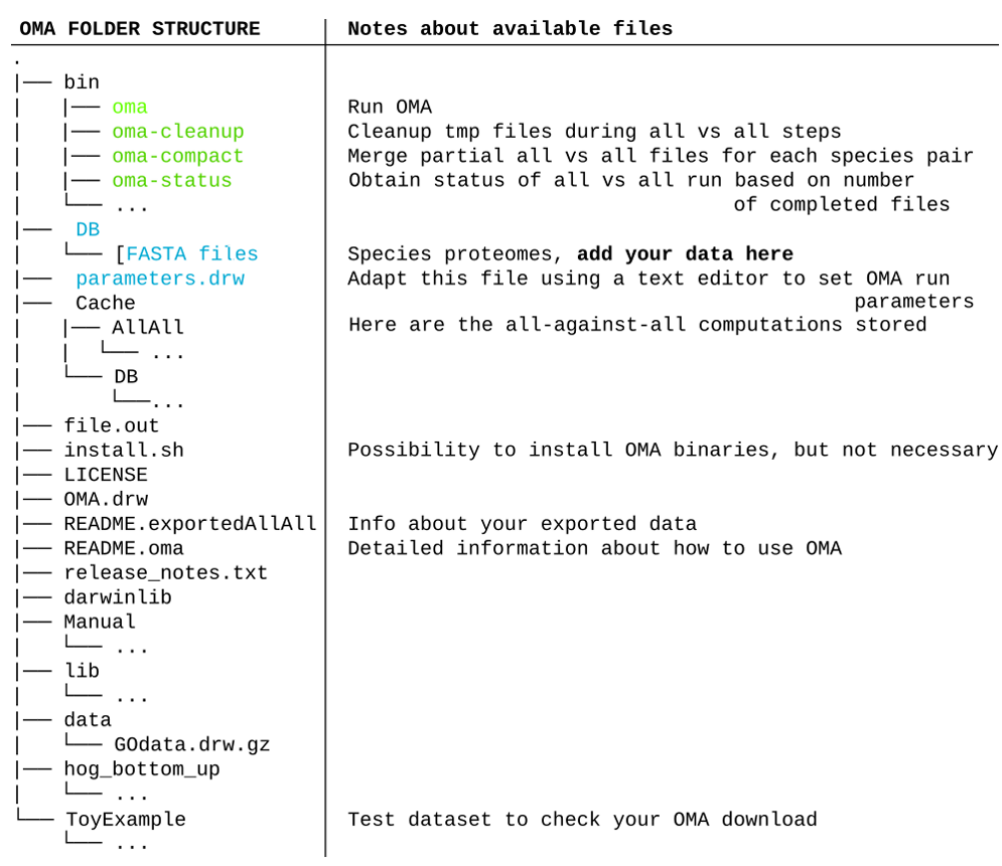
Figure 2. Tree organization of the tarball downloaded through the OMA Browser after exporting an all- against-all of selected species. The important files and folders are colored. In green, the executable files mentioned in the course of the tutorial. In blue are the files and folder that will need to be modified. Other files and folders (in black) will not be used in the course of the tutorial. Files and folders not shown are represented by three